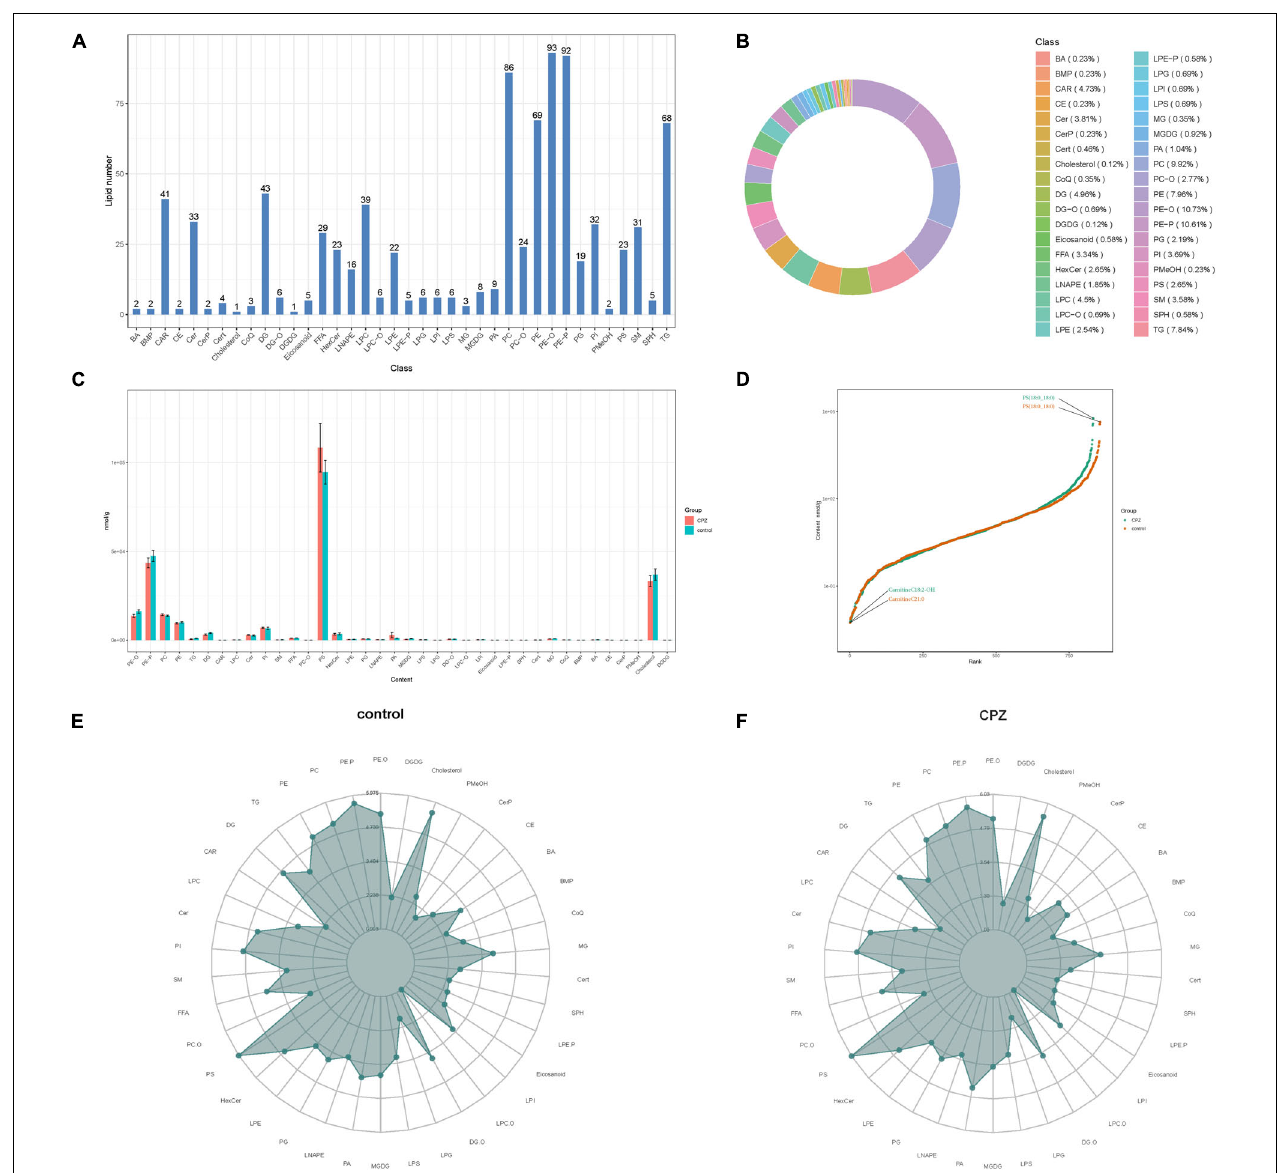
FIGURE 3 | (A) The histogram of lipid subclass. (B) The ring diagram of lipid subclass composition (each color represents a lipid subclass, and the area of the color block indicates the proportion of that subclass). (C) The histogram of changes in lipid subclass content between CPZ and control groups. (D) The plot of dynamic distribution for lipid content (Each point in the graph represents a lipid molecule. The vertical coordinates represent the content corresponding to each lipid molecule, and the lipid molecules with the lowest and highest content are marked. Different color curves represent different groupings). (E,F) The radar charts of the content of the lipid metabolites between the CPZ and control groups (The grid lines indicate the LG categorical content, and the green shading consists of the line connecting each categorical